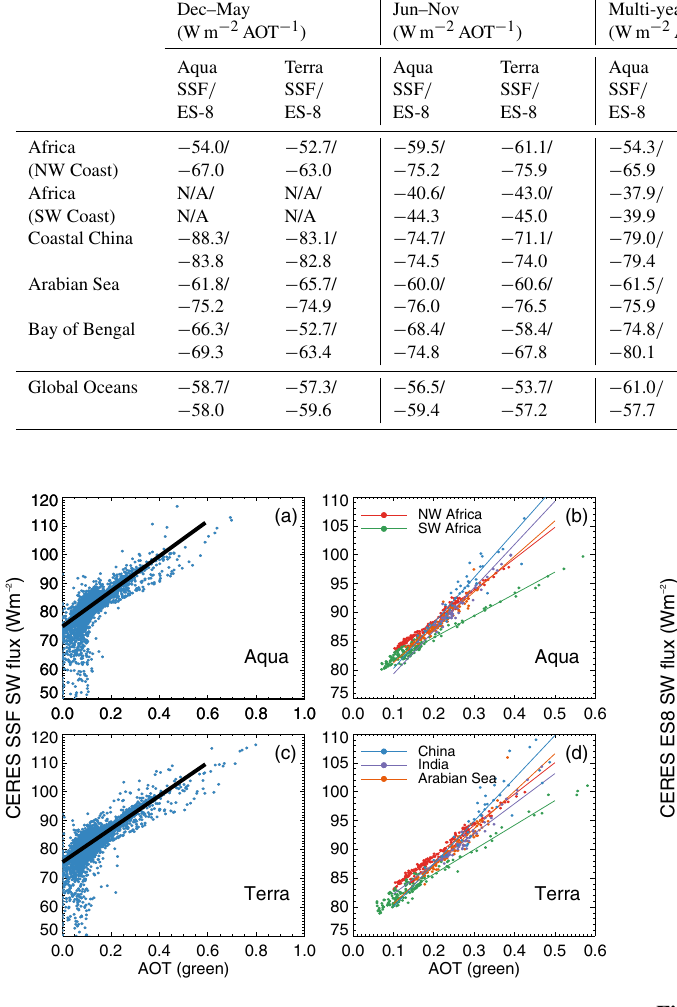
Figure 6. (a) Scatterplot of Aqua MODIS AOT vs. CERES SSF SW flux (cloud-free, at a 2 ◦ × 2 ◦ resolution) using data as shown in Fig. 5. Color lines are for selected regions, and the thick black line is for global oceans. (b) Similar to (a) , but for five selected regions that have a maximum AOT > 0 . 3 as indicated from Fig. 5.